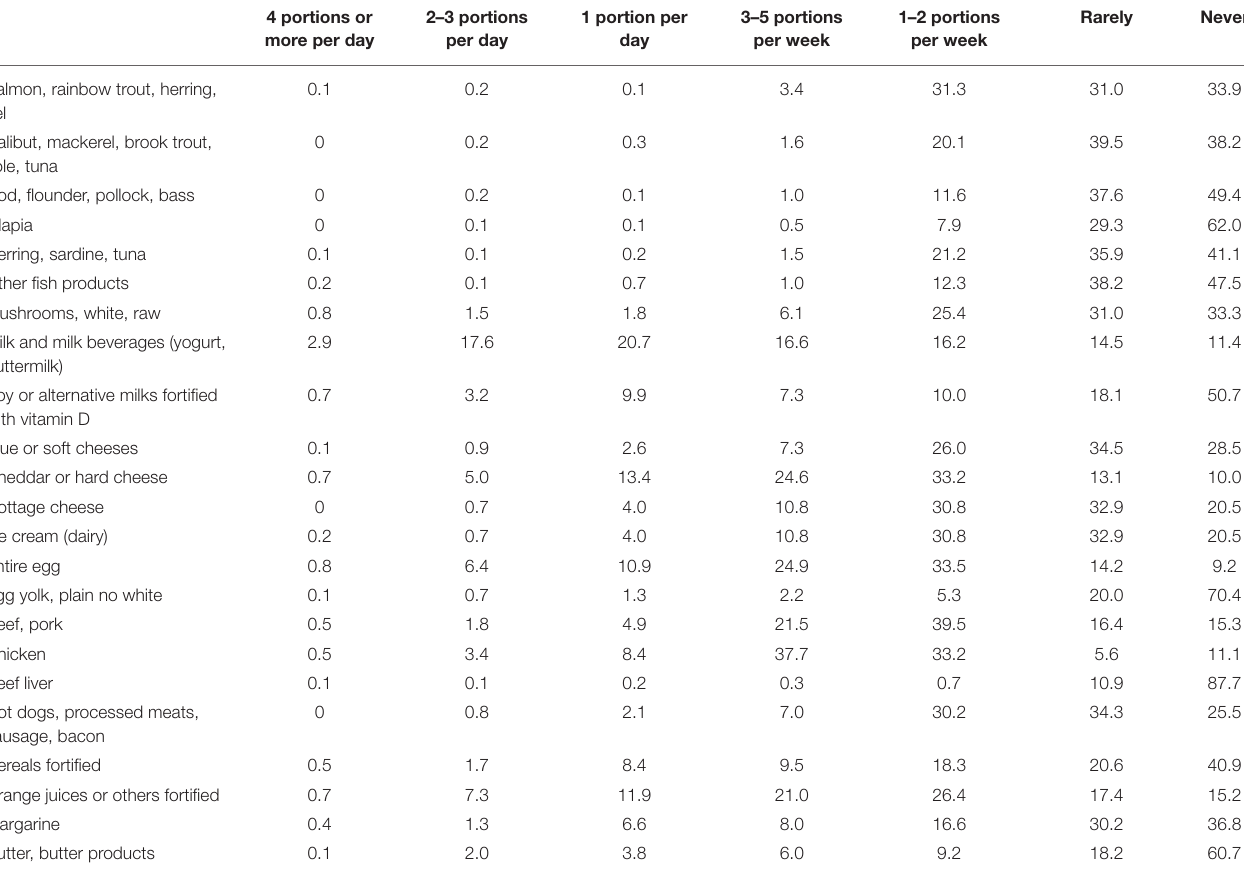
TABLE 2 | Percent frequency of consuming vitamin D in foods and beverages ( n =